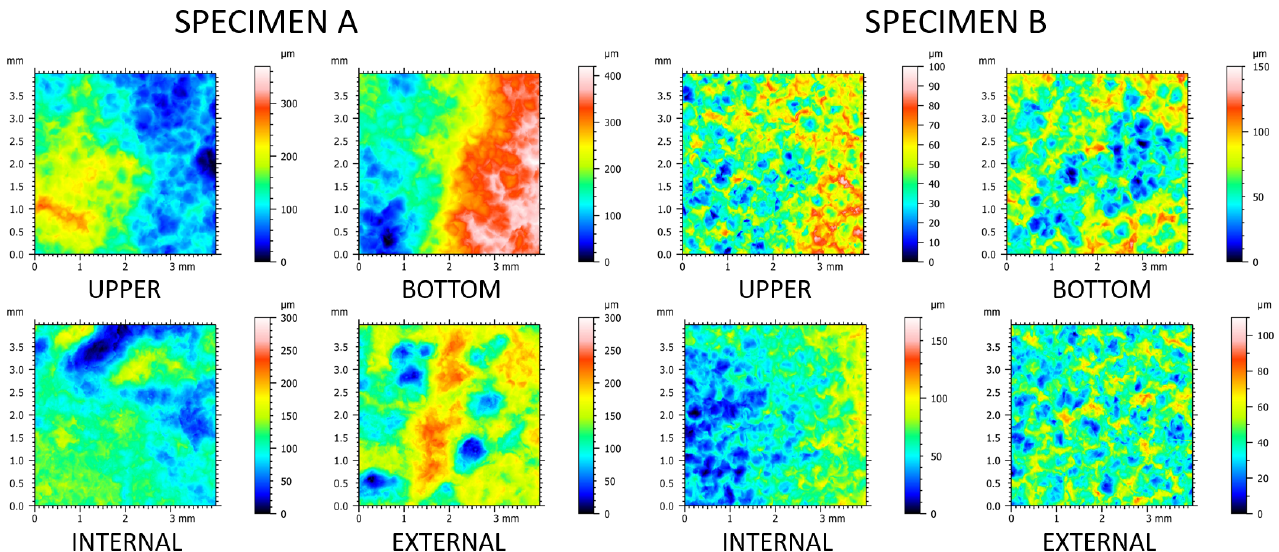
Figure 4. Renderings of topographic measurements capturing four different locations: upper, bottom, internal, and external of each of the two rings A and B.